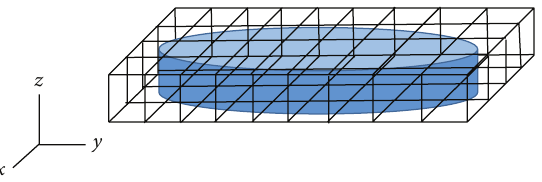
Figure 1: Region division of a generic geometry in the